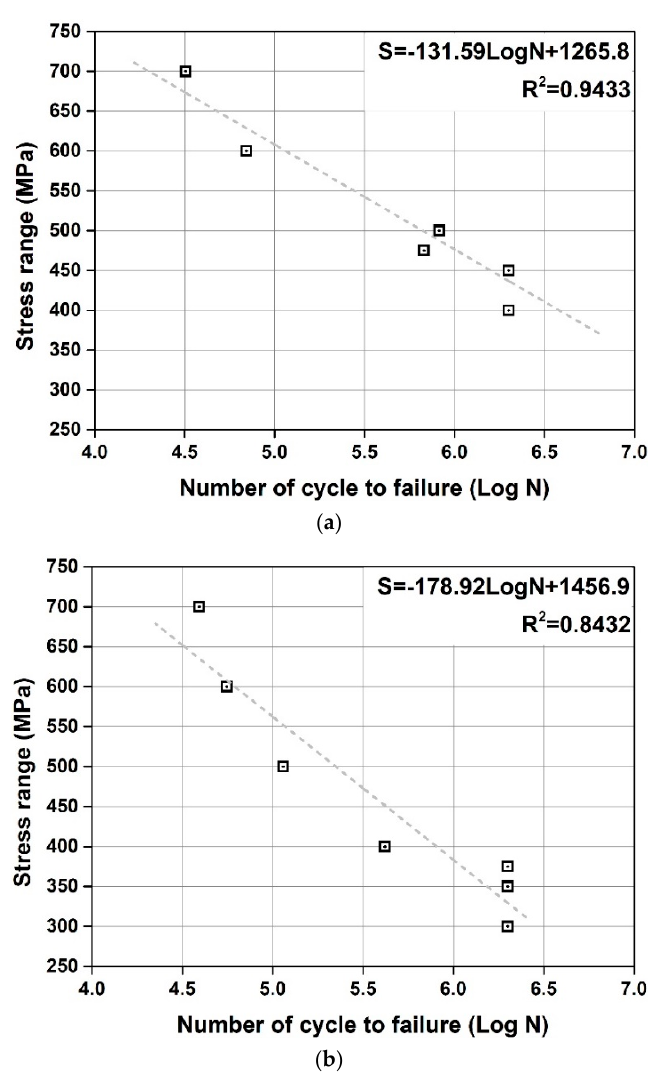
Figure 9. S–N relation according to type of alloy. ( a ) A-type; ( b ) B-type.